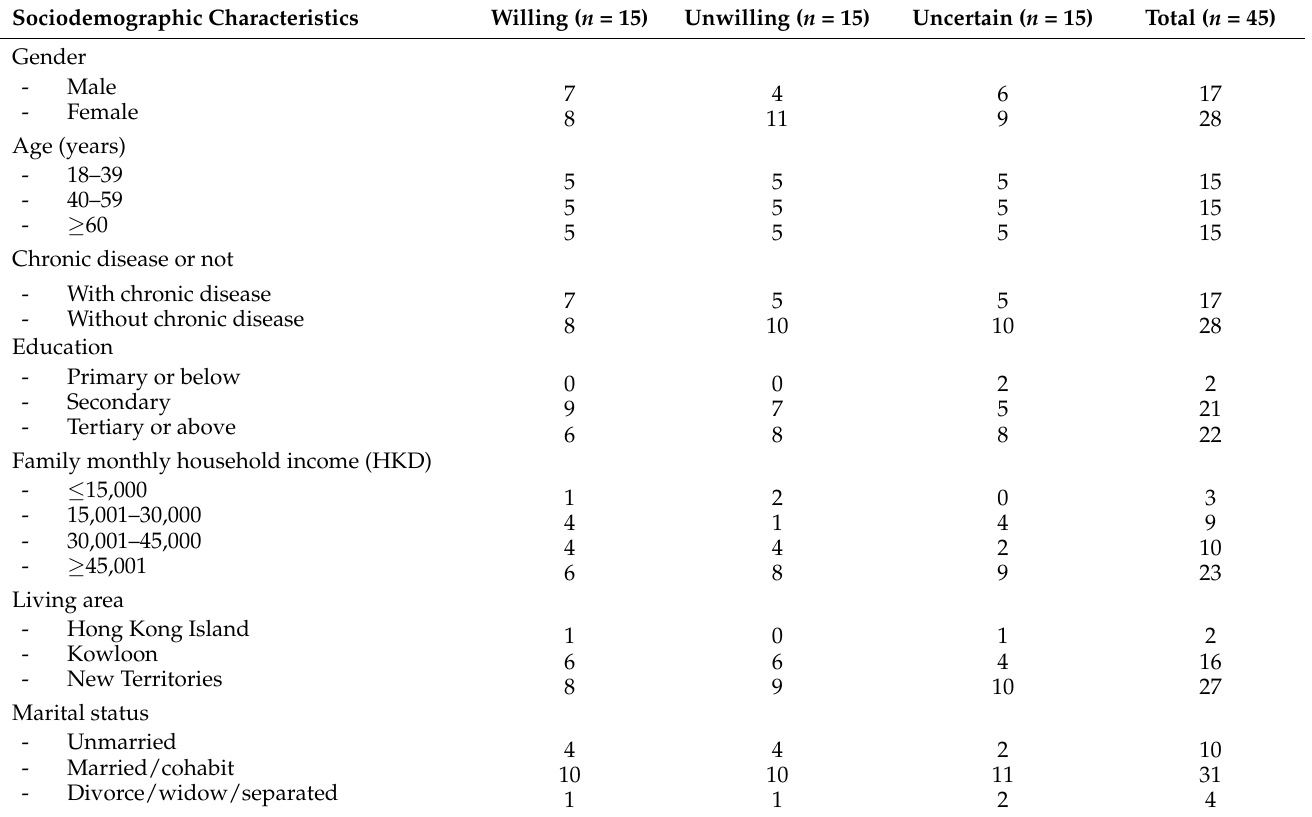
Table 1. Sociodemographic characteristics of participants ( n =